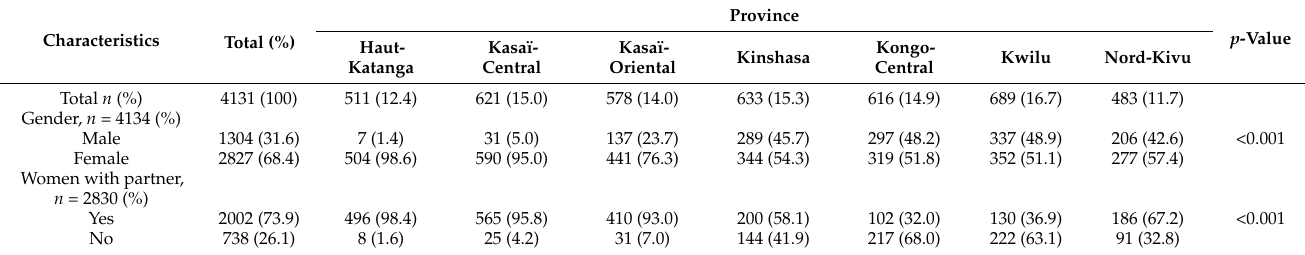
Table 1. Participants’ characteristics by